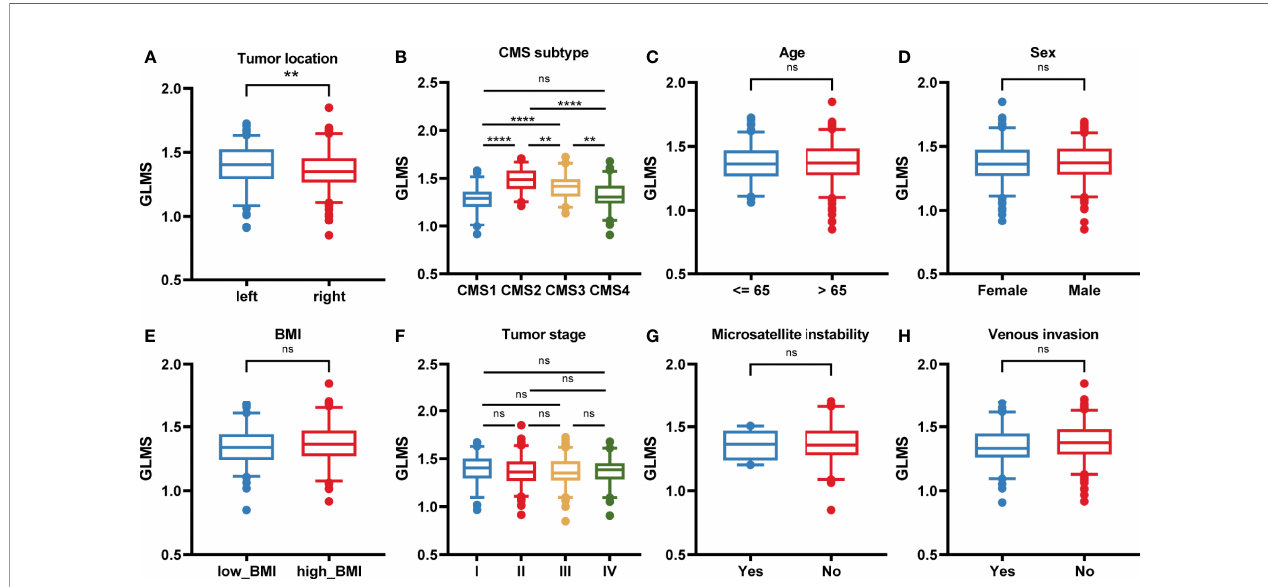
FIGURE 3 | The association between the glycerolipid metabolism score and clinical features. (A – H) The glycerolipid metabolism score (GLMS) distribution in patients with different clinicopathologic features including tumor location (A) , and consensus molecular subtype (CMS) (B) , age (C) , sex (D) , body mass index (BMI) (E) , tumor stage (F) , microsatellite instability status (G) , and venous invasion status (H) . ns (non-signi fi cant) P > 0.05, ** P < 0.01 and **** P < 0.0001 by the Wilcoxon